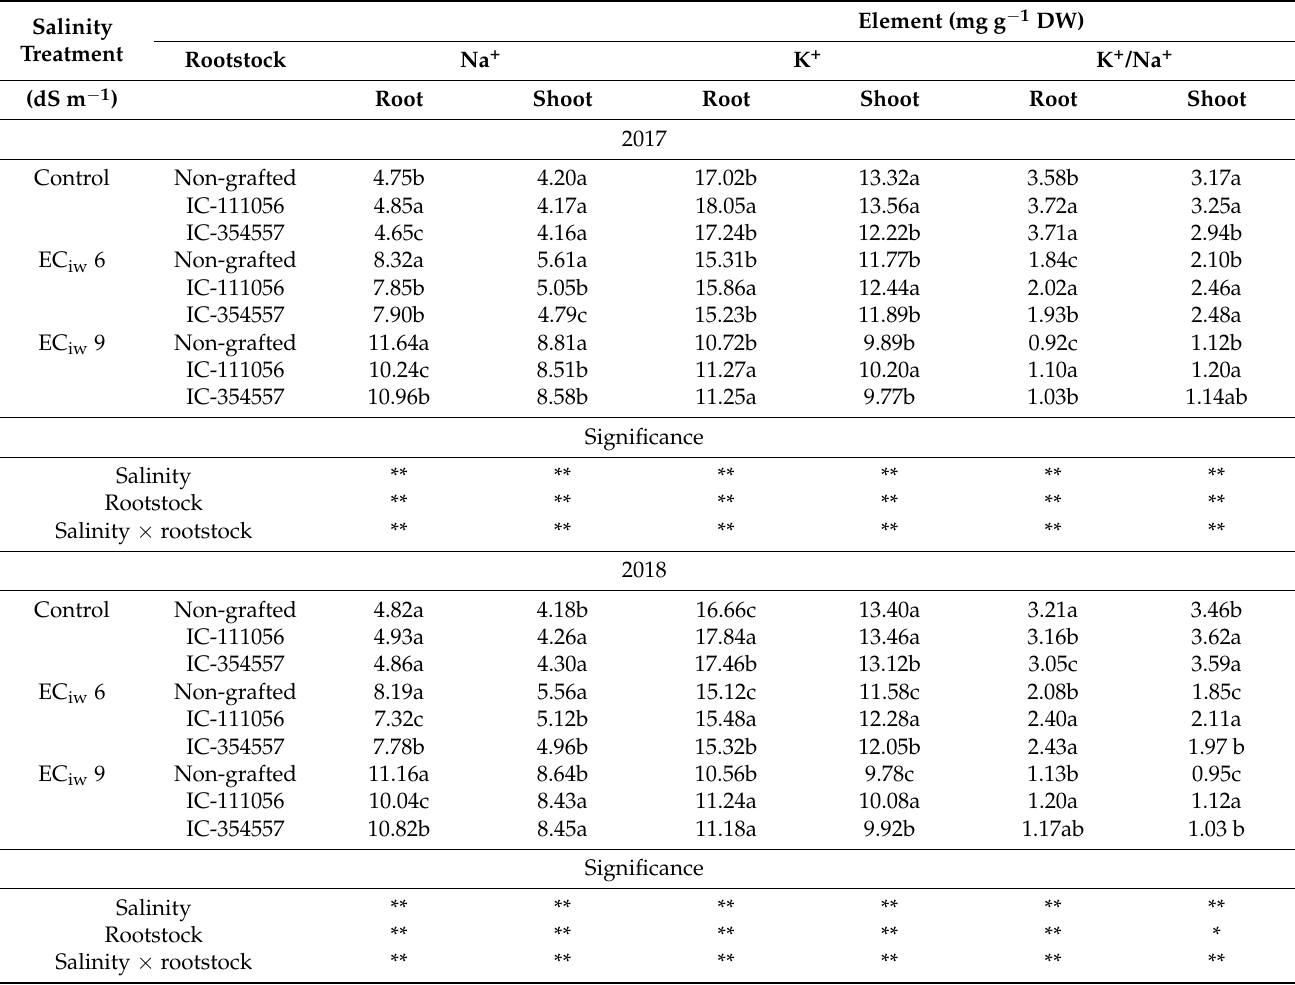
Table 4. Effect of salinity treatments on Na + and K + contents as well as K + /Na + ratios of root and shoot parts of grafted and non-grafted tomato plant (cv. Kashi